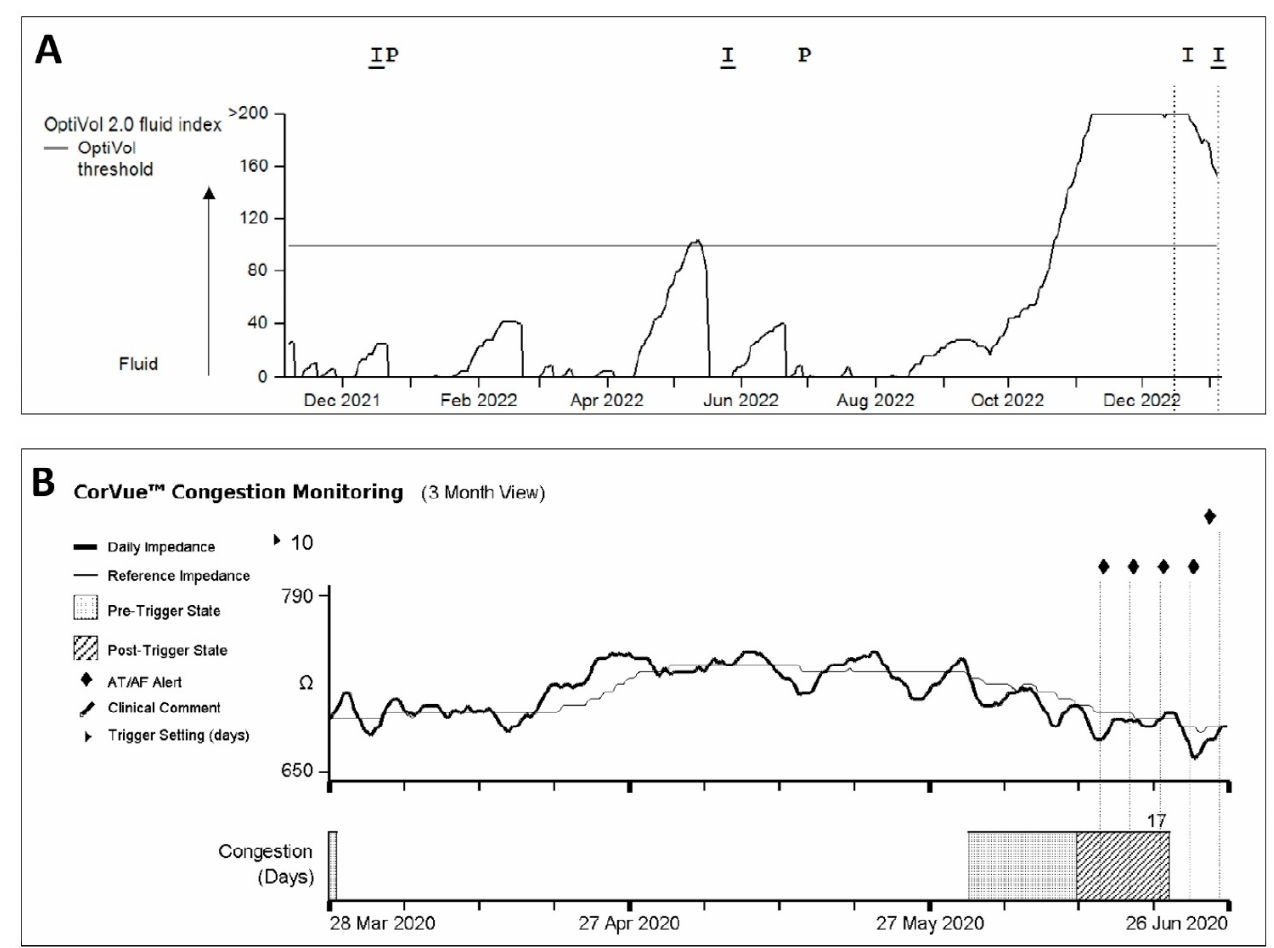
Figure 1. Example of ( A ) Optivol TM and ( B ) CorVue TM algorithm trends available in Medtronic and Abbott CIEDs, respectively.